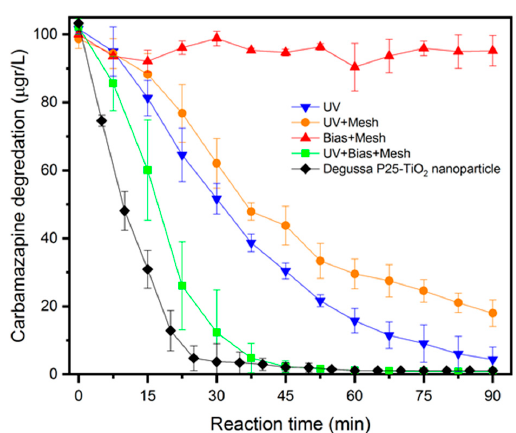
Figure 3. Degradation of carbamazepine by photoelectrocatalysis (UV + Bias + Mesh), photocatalysis on the TiO 2 mesh (UV + Mesh), electrochemical oxidation (Mesh + Bias), photolysis (UV) and conventional photocatalysis (UV + Degussa